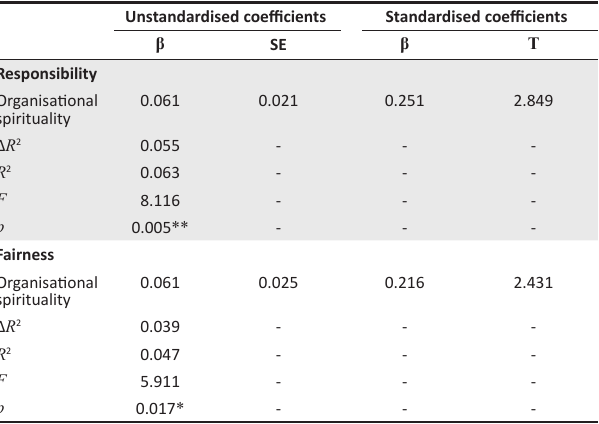
TABLE 3: Multiple regression analysis results of organisational spirituality, responsibility and